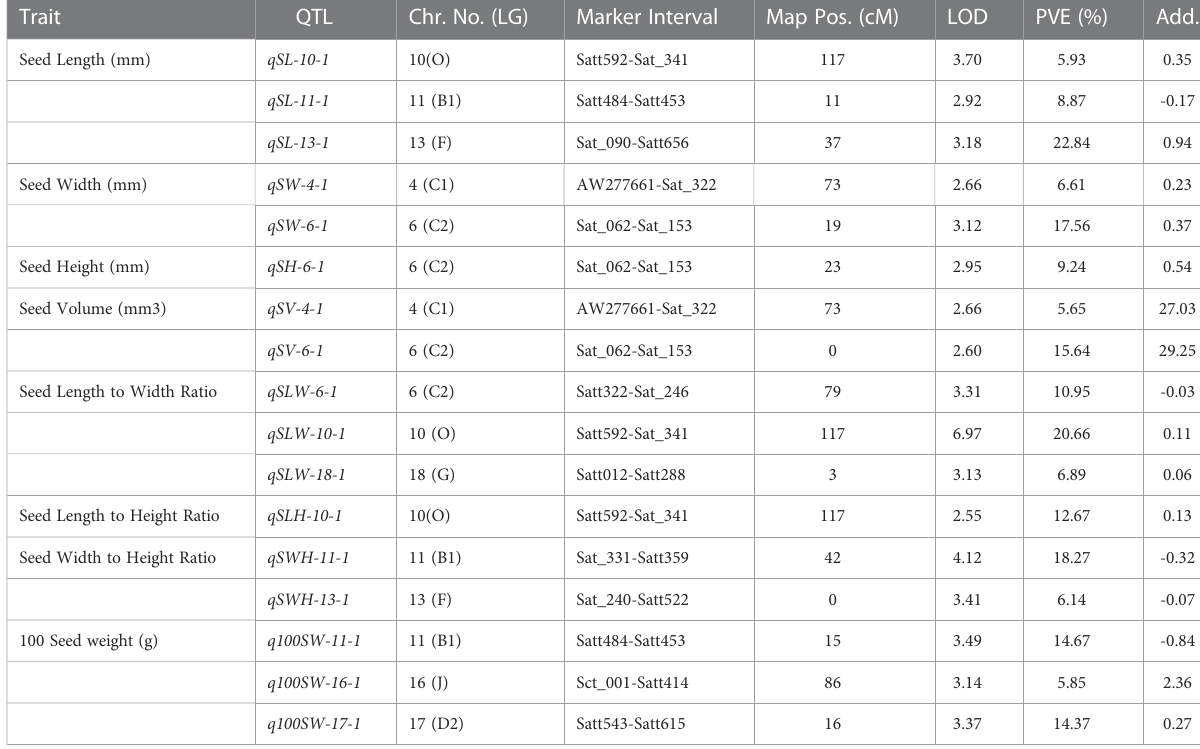
TABLE 4 QTLs identi fi ed for seed-related traits in the F 2 mapping population derived from AGS 457 X SKAF 148. Trait QTL Chr. No.